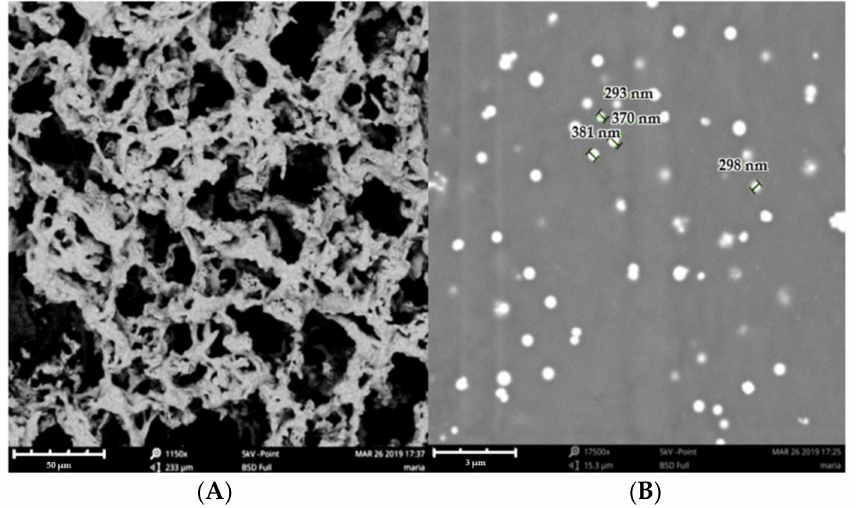
Figure 2. ( A ) Image of PF-NLCs-F127 hydrogel by SEM (structure); ( B ) Image of PF-NLCs-F127 hydrogel by SEM (size).